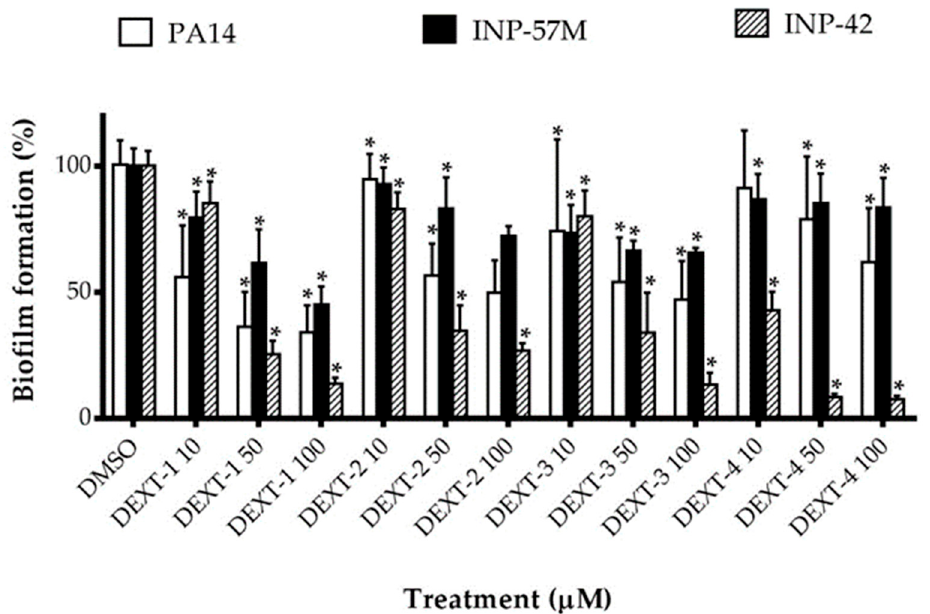
Figure 3. Effect of halogenated pyrrolidones on biofilm formation of P. aeruginosa PA14 WT and clinical isolates (INP-57M and INP-42). Values are presented as means ± SD. The Student’s t -test was used to calculate the differences between two mean values (* p < 0.05) .